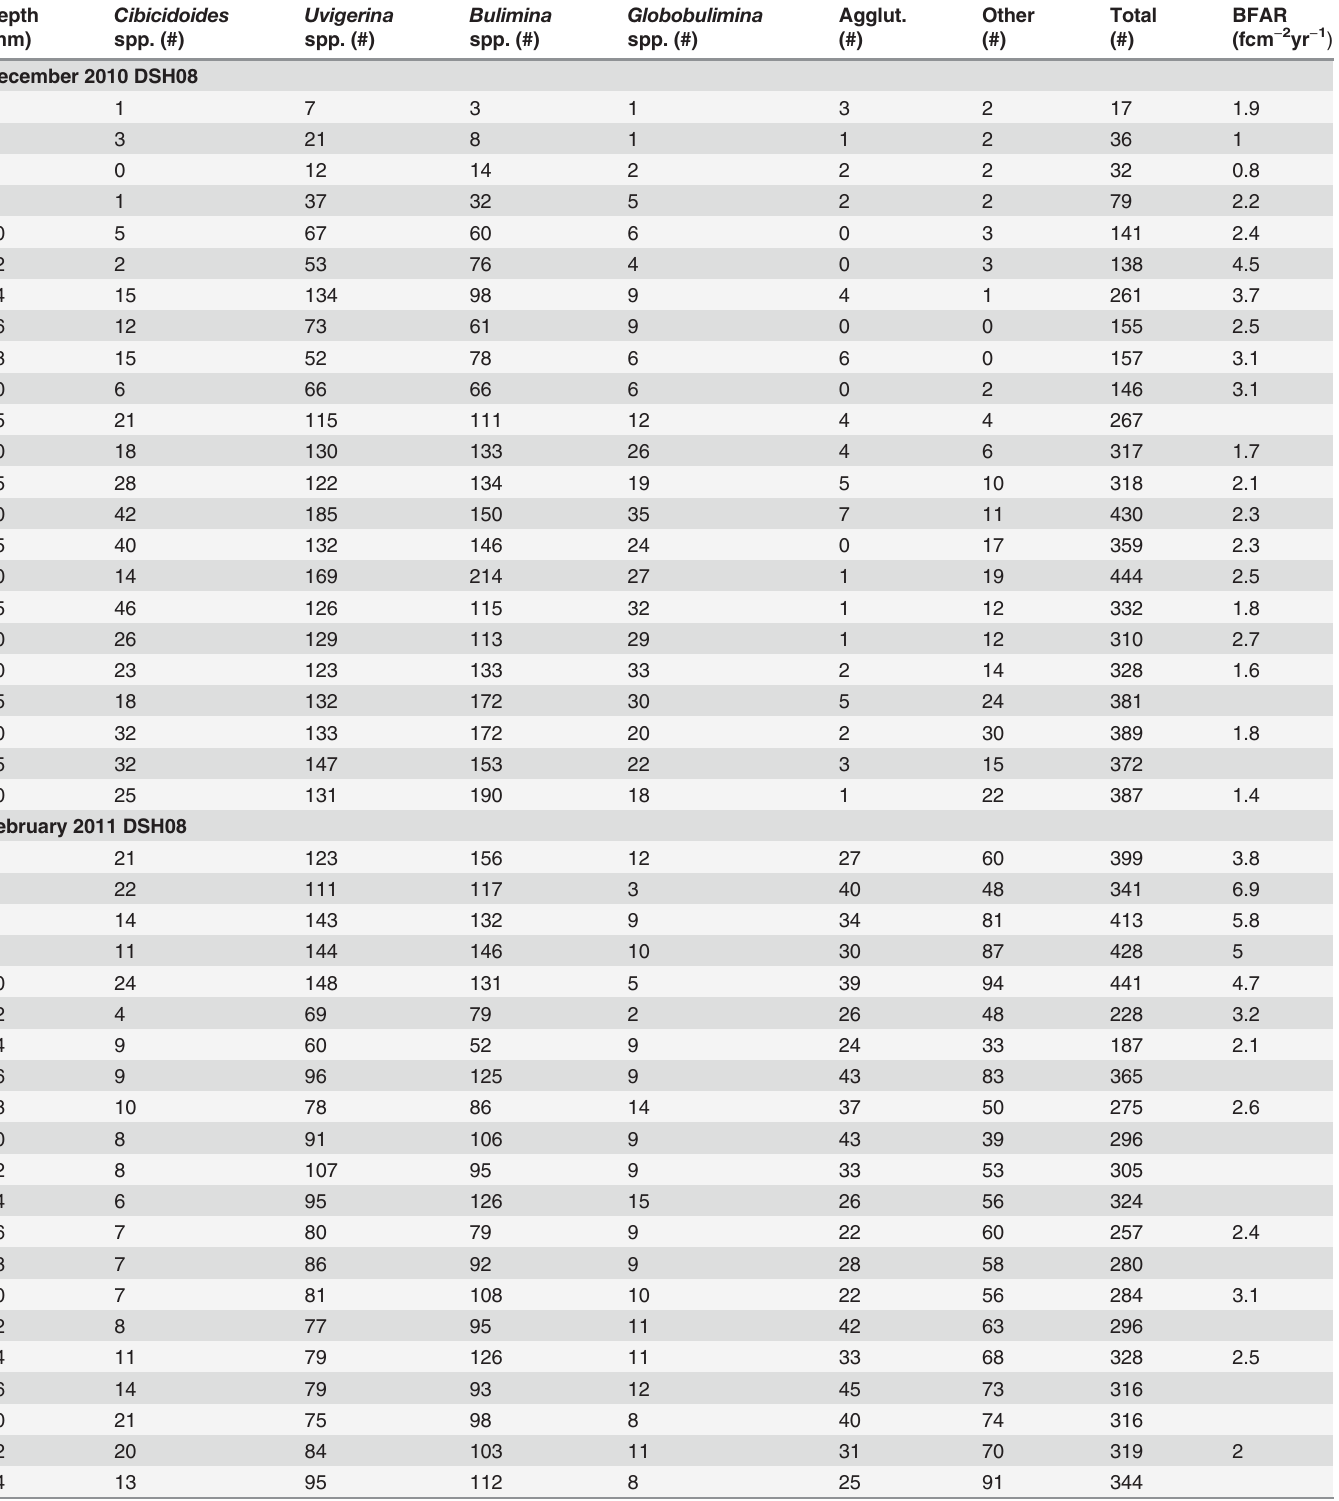
Table 2. Number of dominant genera with depth for each core and the corresponding BFAR. Depth Cibicidoides Uvigerina Bulimina Globobulimina Agglut. spp.